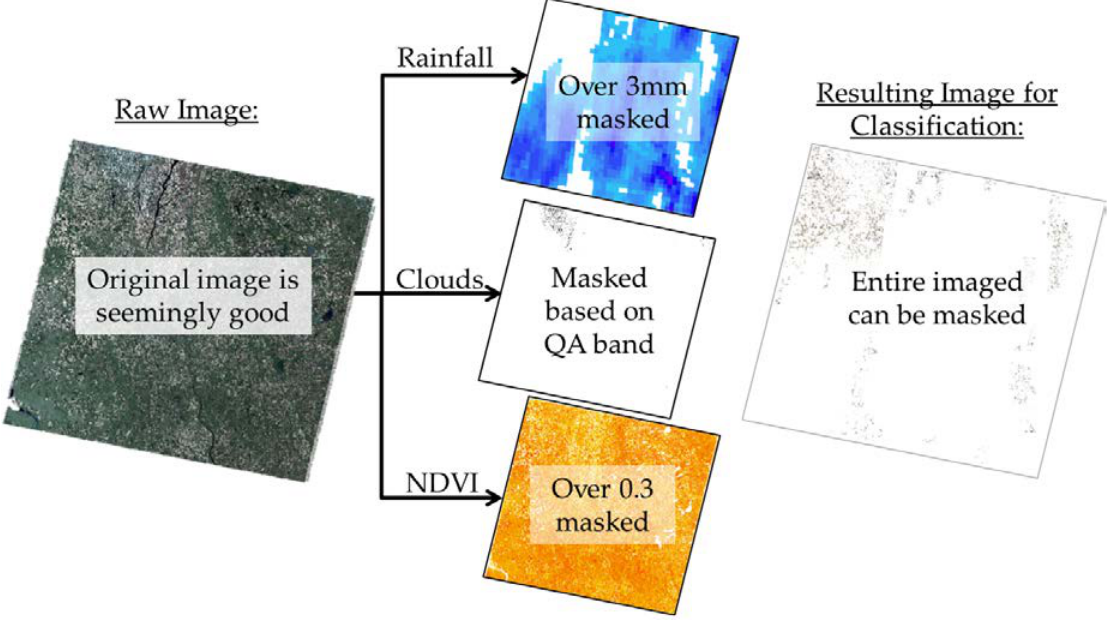
Figure 5. The result of masking one satellite image from 2007 based high soil moisture (2-day rainfall sum over 3 mm), clouds or cloud shadows, and/or 3) green vegetation (NDVI over 0.3). (Conceptual figure and not to scale, a Landsat image size is 185 km × 180 km.).